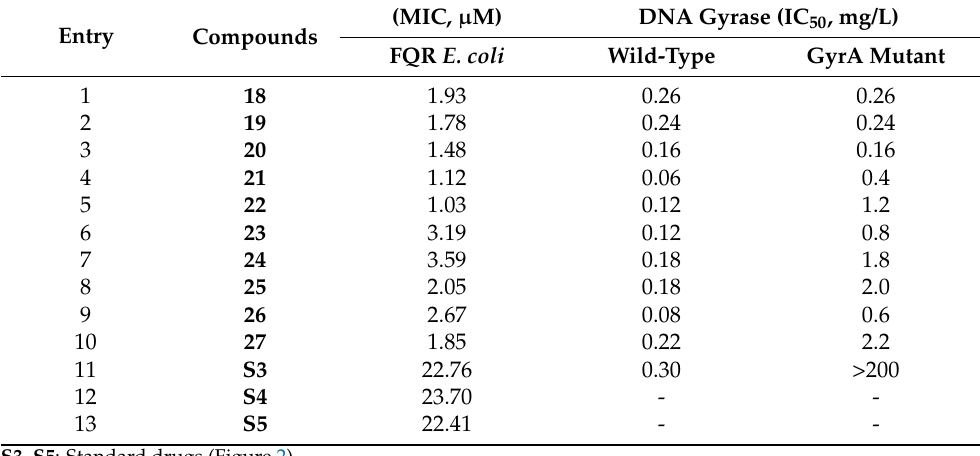
Table 3. Antibacterial and DNA gyrase inhibitory properties of compounds 28–37